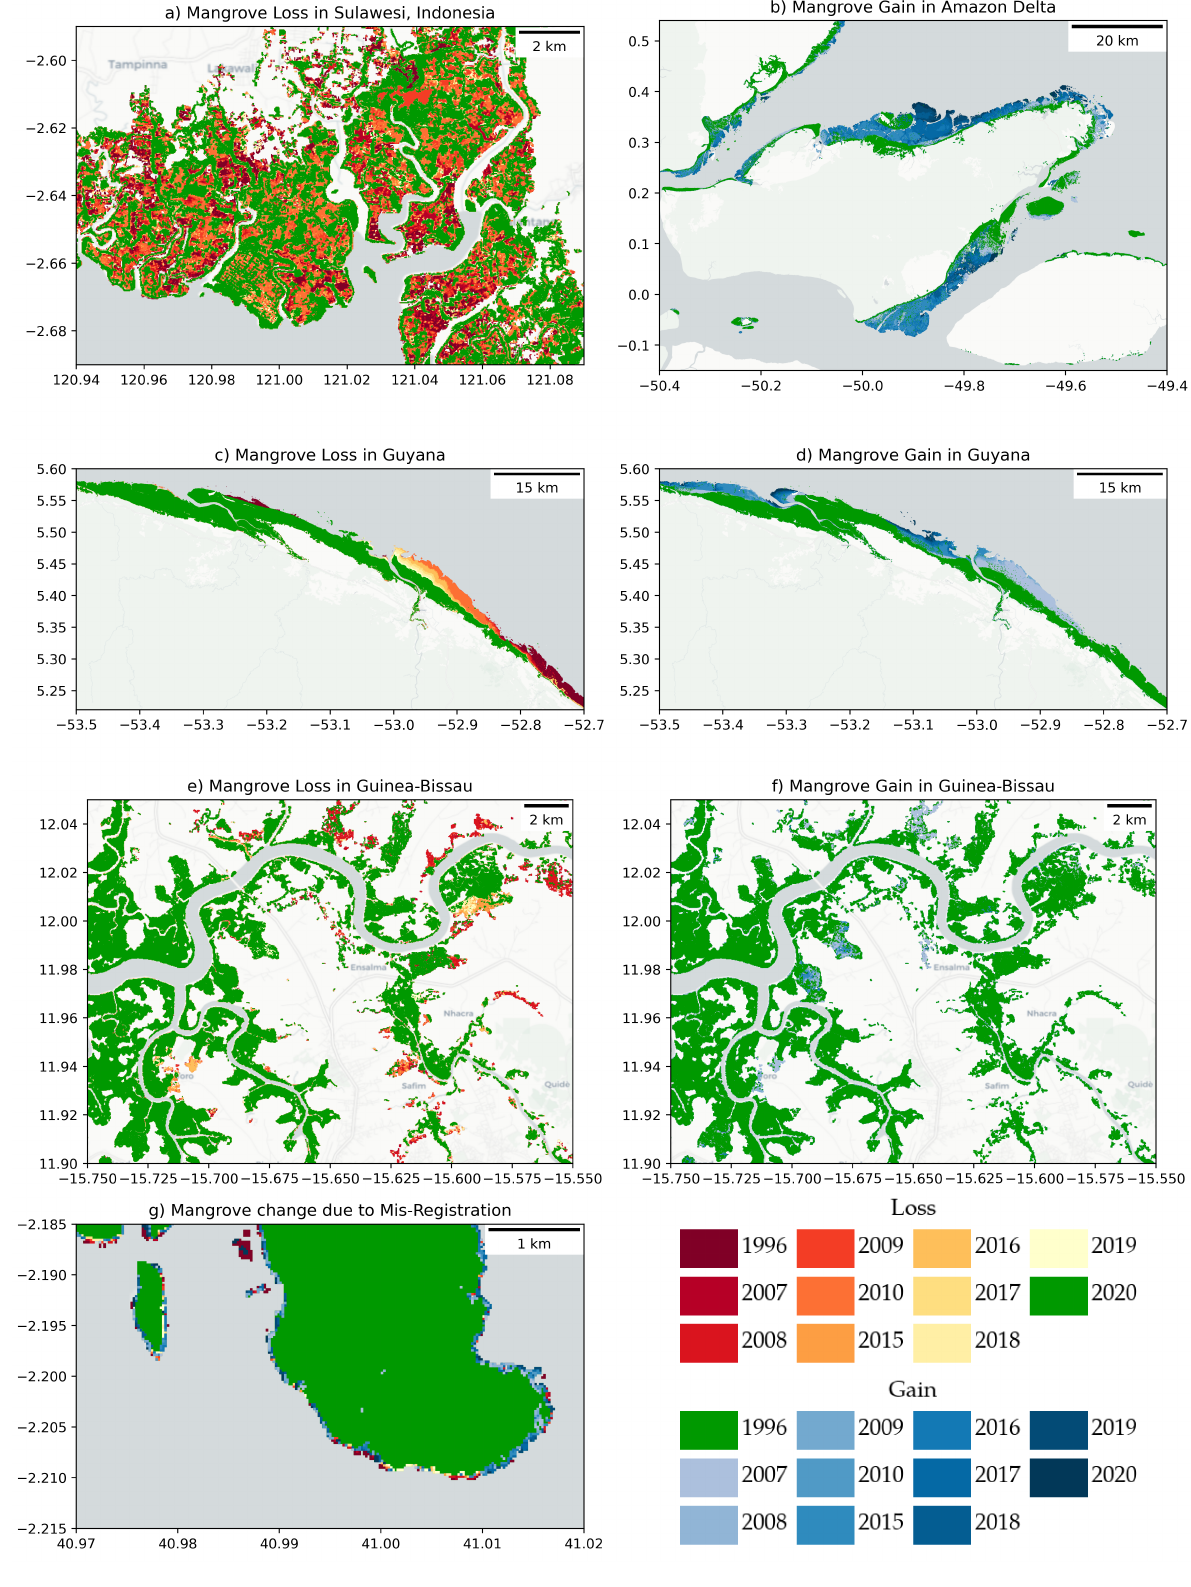
Figure 9. Examples of the mangrove change results. ( a ) Mangrove loss in Sulawesi, Indonesia, ( b ) Mangrove gain in Amazon Delta, ( c , d ) natural mangrove dynamics in Guyana, ( e , f ) anthropogenic mangrove dynamics in Guinea-Bissau and ( g ) an example of false mangrove gain and loss due to